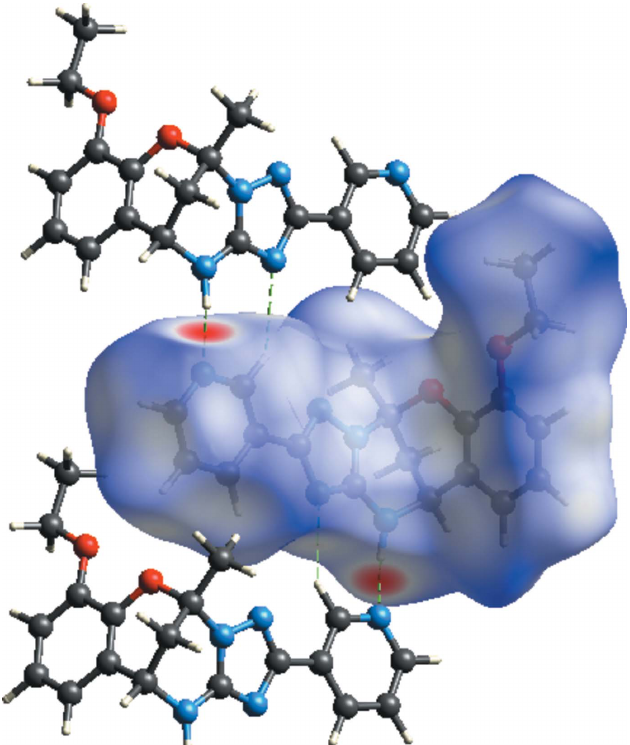
Figure 4 d norm mapped on Hirshfeld surfaces to visualize the intermolecular interactions of C 19 H 19 N 5 O 2 overall Hirshfeld surface of 52.6% (Fig. 6). The contribution from the N (cid:2) (cid:2) (cid:2) H/H (cid:2) (cid:2) (cid:2) N contacts, corresponding to the N— H (cid:2) (cid:2) (cid:2) N interaction, is represented by a pair of sharp spikes characteristic of a strong hydrogen-bond interaction (16.3%).